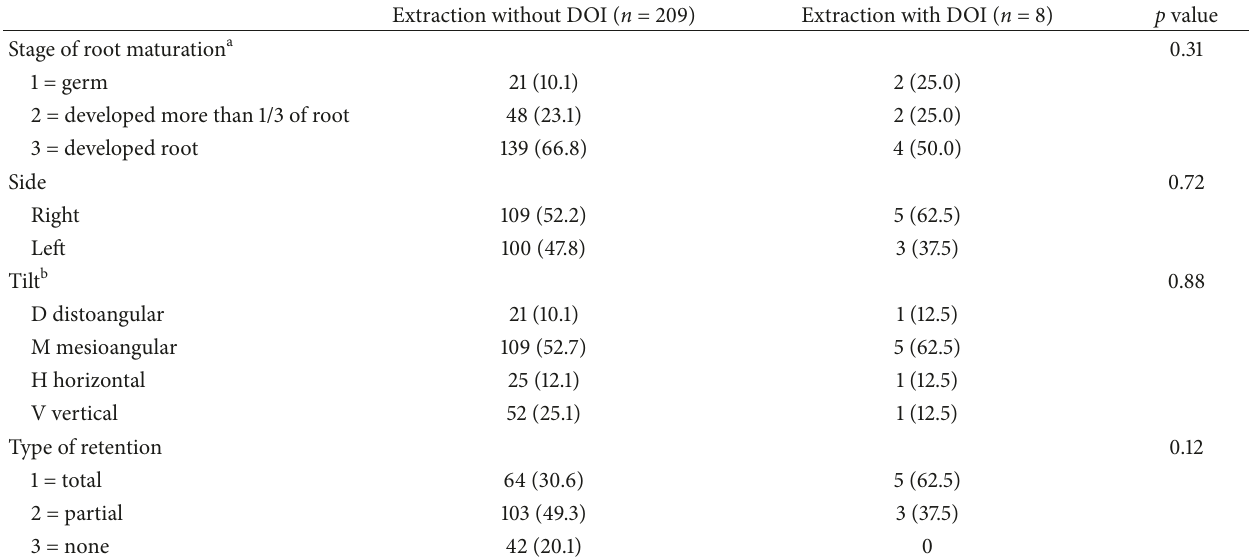
Table 3: Features of the extracted